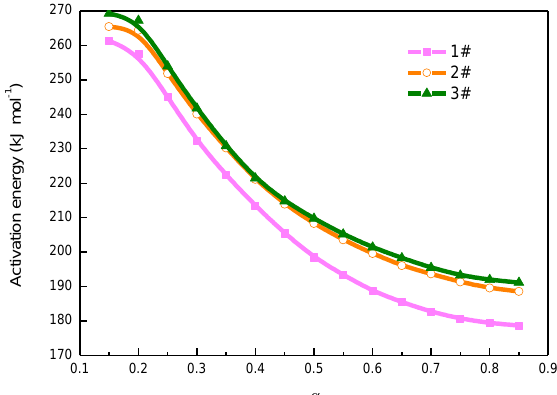
Figure 6. The activation energy estimated using the integral isoconversional model of Miura–Maki for coal sample with different particle sizes.